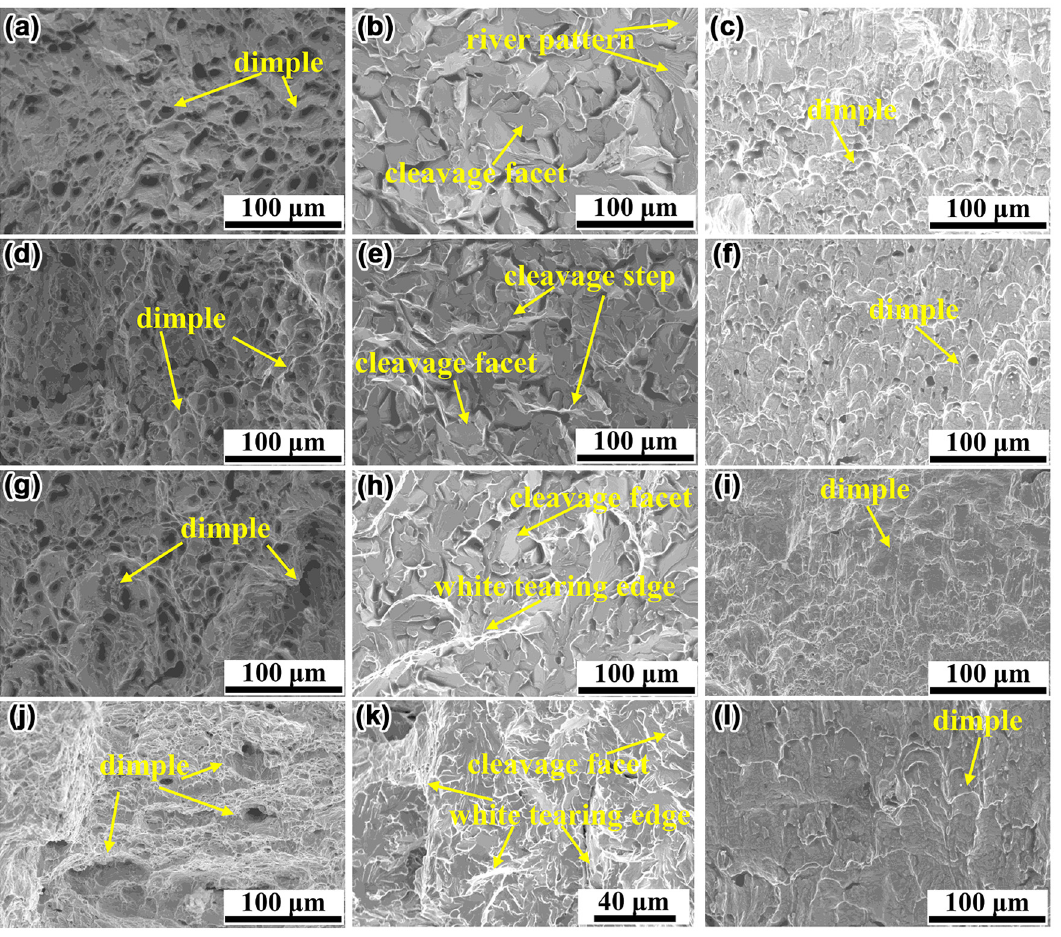
Figure 8. The micromorphology of the fibrous crack zone ( a , d , g , j ), the stretch zone ( b , e , h , k ), and the tip blunting zone ( c , f , i , l ) in N1, N2, N3, and N4 steel, respectively.